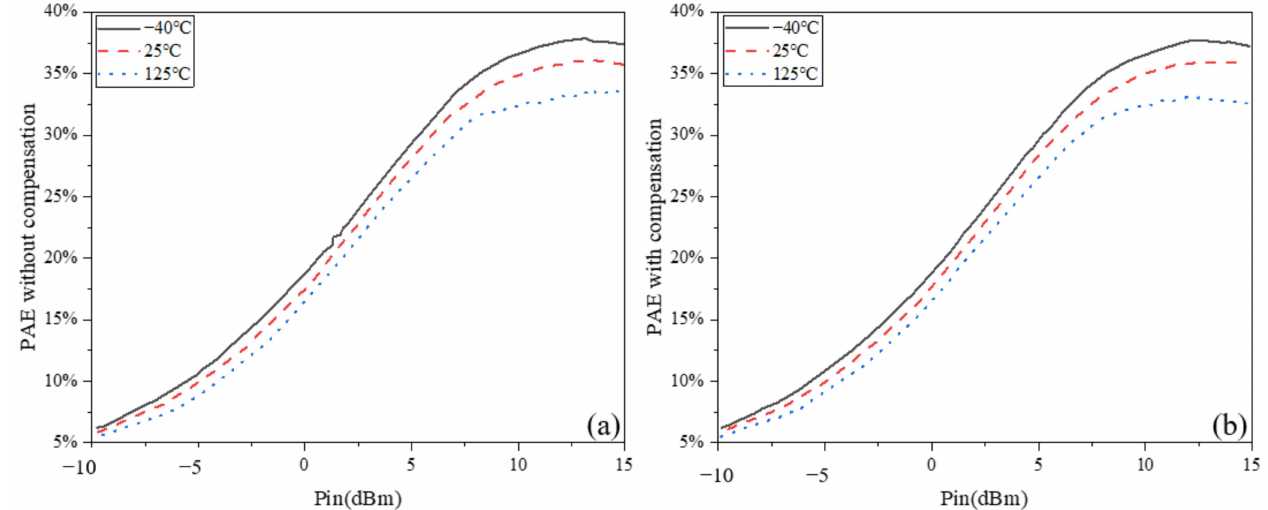
Figure 9. PAE versus temperature variation: ( a ) without temperature compensation; ( b ) with temper- ature compensation.